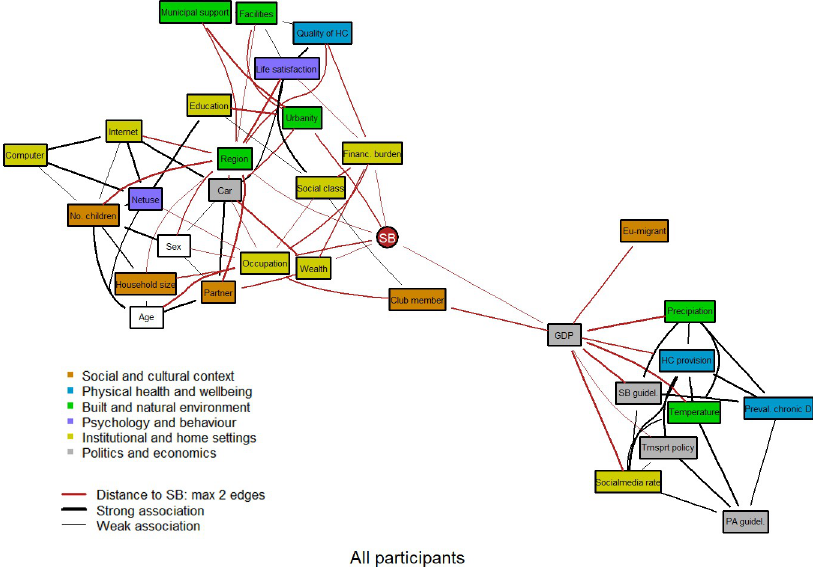
Fig 1. Graph depicting the Bayesian network of 33 factors for the complete study sample (N = 23,865).